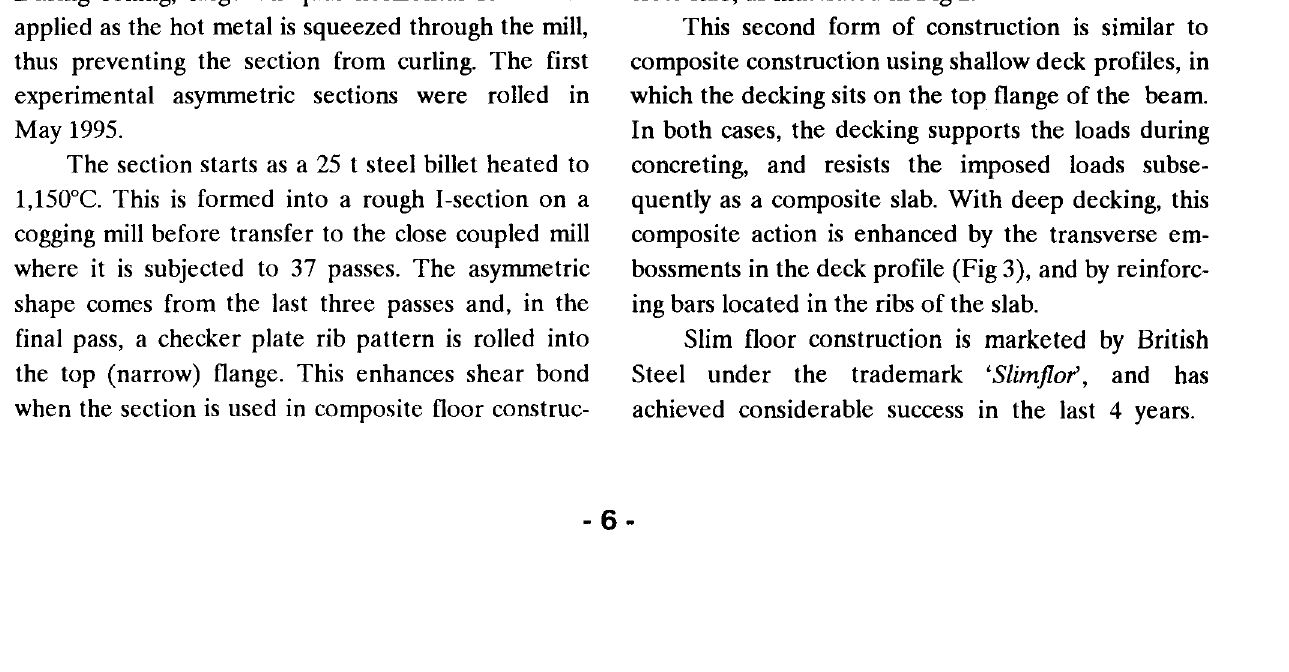
Fig 2. Conventional slim floor construction using UC beam and deep